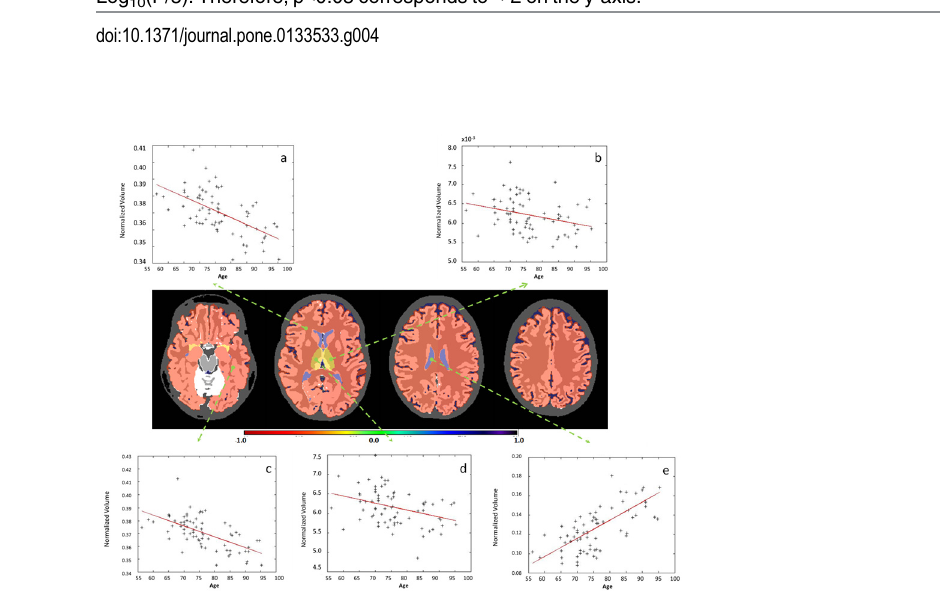
Fig 5. Examples of significant correlations between regional volumes and age at granularity level 1. The colors code the correlation coefficient R in regions where the age vs. volume curve achieves significance (p-value < 0.05, Bonferroni-corrected). Yellow / orange / red (R < 0) are regions that shrink over time, while blue (R > 0) are regions that expand over time, such as ventricles. As is shown in the figure: a. telencephalon (right); b. diencephalon (left); c. telencephalon (left); d. diencephalon (right); e. cerebrospinal fluid.